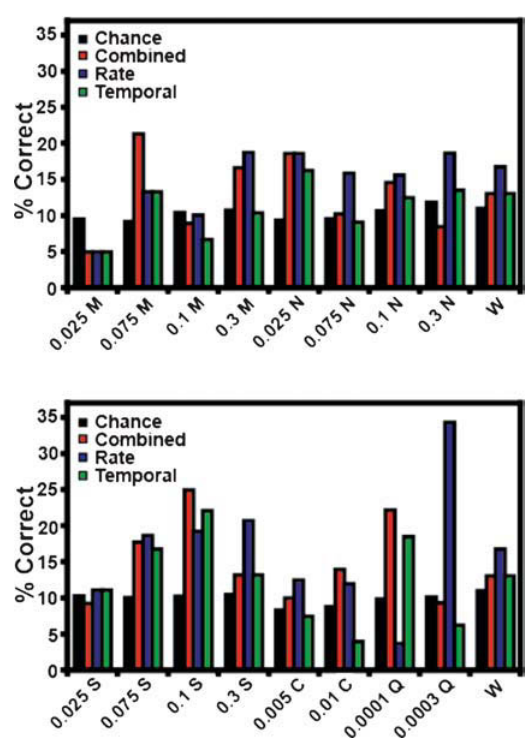
Figure 10. Tastant predictions for the unreinforced lick data. The conven- tions for this figure are the same as those in Figure 5 . While all three models